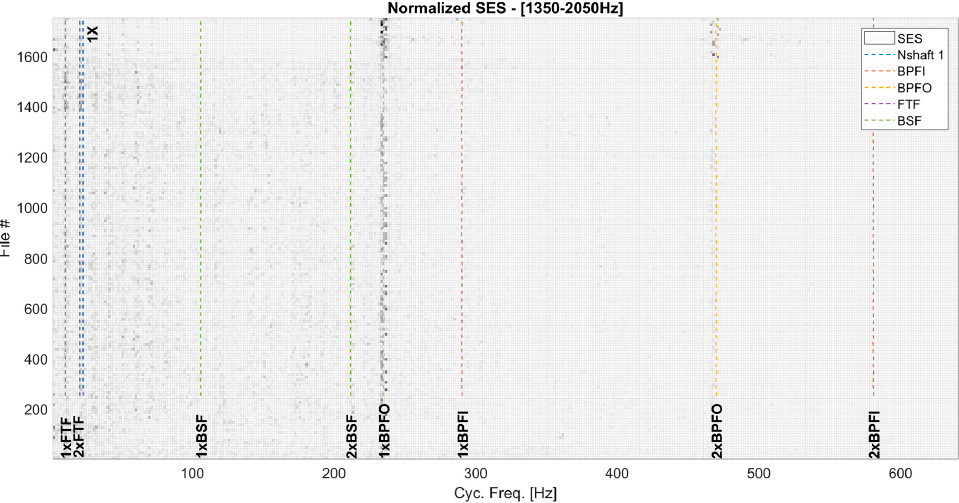
Figure 13. Normalized SES map, i.e., top view of Figure 12, first frequency band—right TB.